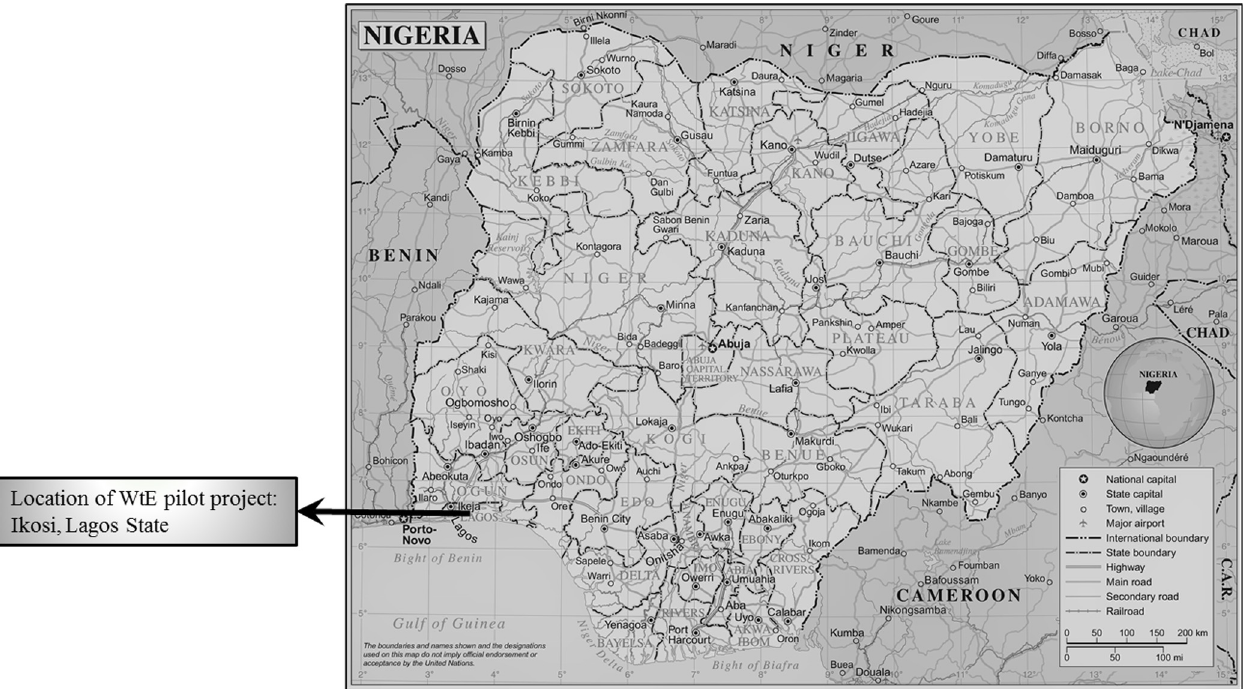
Fig. 2. Map of Nigeria showing the 36 states and the FCT, Abuja